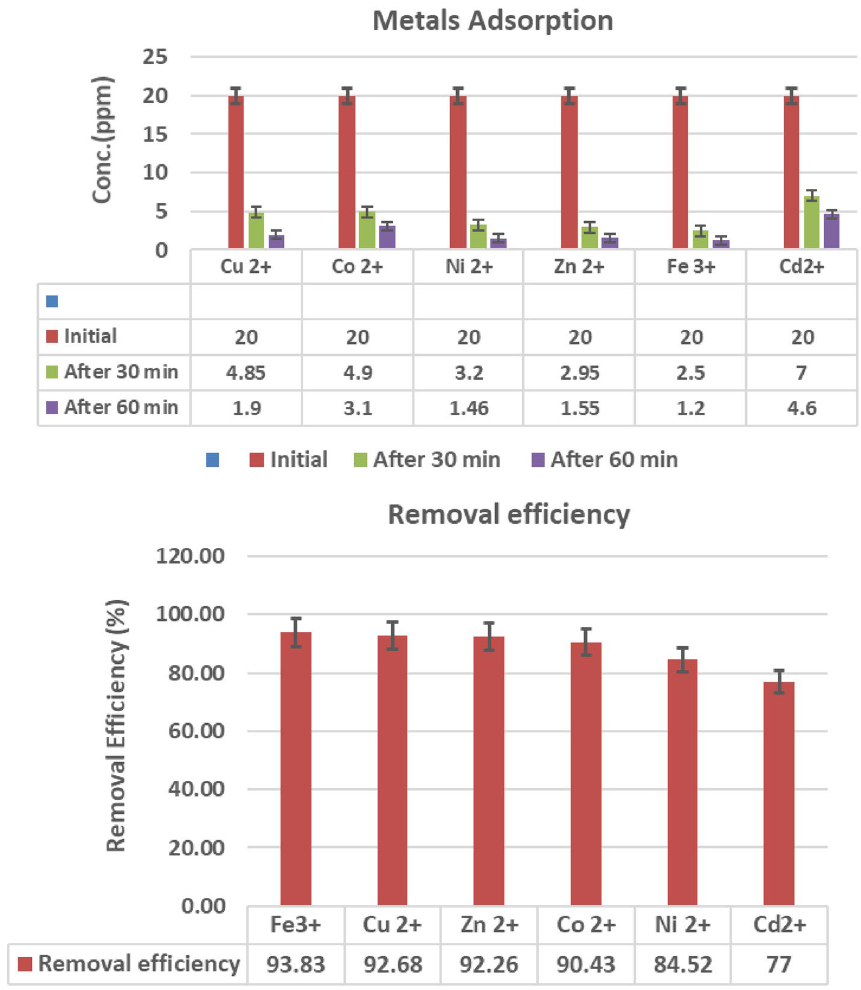
Figure 9. The top chart shows flame atomic adsorption of heavy metals after 30 and 60 min of treatment with 0.05 gm of PAK, which describes the remaining concentration of each metal ion, and the down chart shows removal efficiency % of